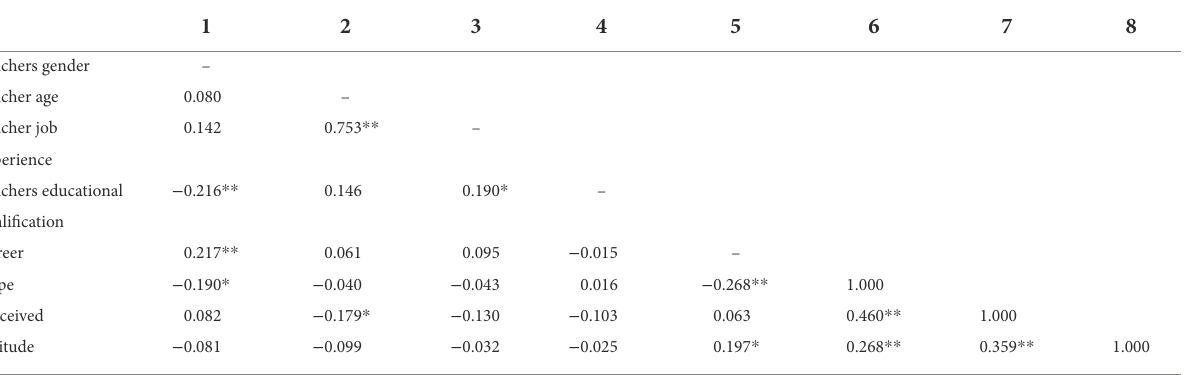
TABLE 2 Correlation between demographic characteristics and burnout